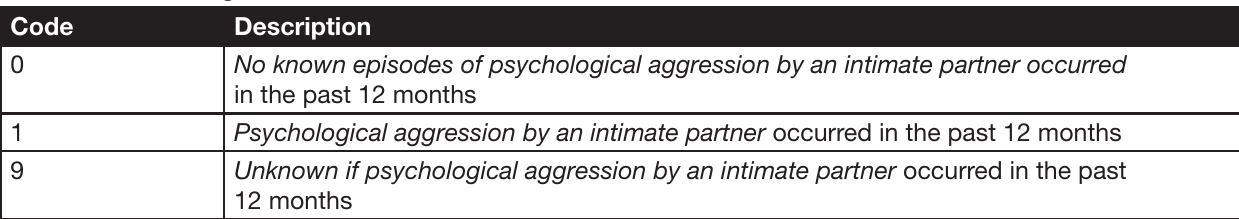
INTIMATE PARTNER VIOLENCE: UNIFORM DEFINITIONS AND RECOMMENDED DATA